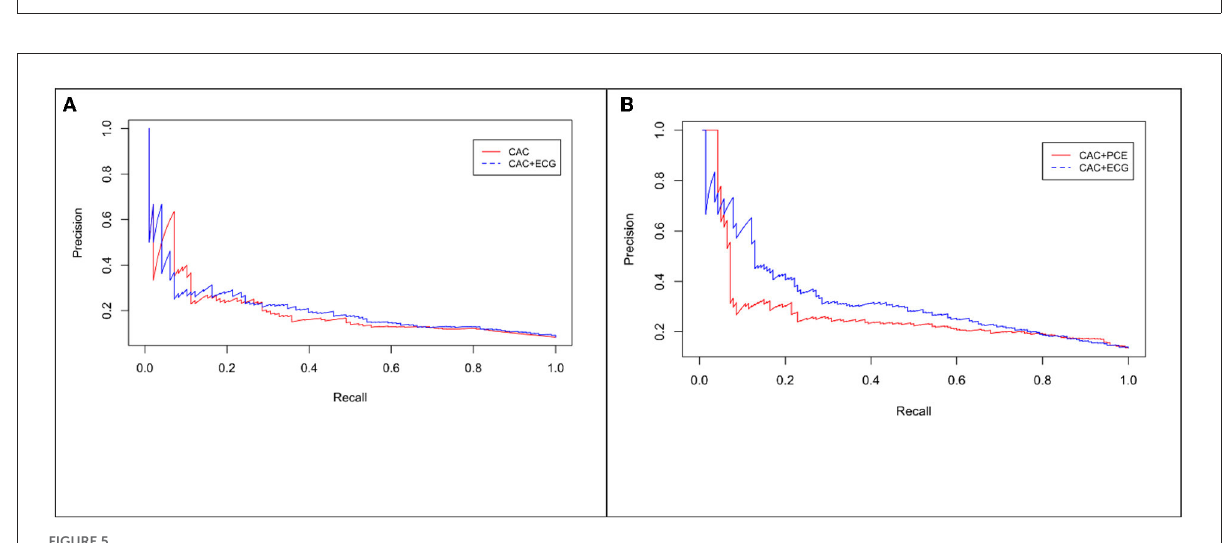
FIGURE5 Precision-Recall (PR) curve for CAC only vs. eRiS + CAC shows the benefit of adding eRiS to CAC for better prediction of the probability of a MACE event in (A) (Average F1 statistic 0.20 vs. 0.21. PR AUC: 0.68 vs. 0.71). (B) CAC + eRiS showed better performance than CAC + PCE for patients who had PCE available (Average F1 statistic 0.28 vs. 0.30. PR AUC: 0.68 vs. 0.71).